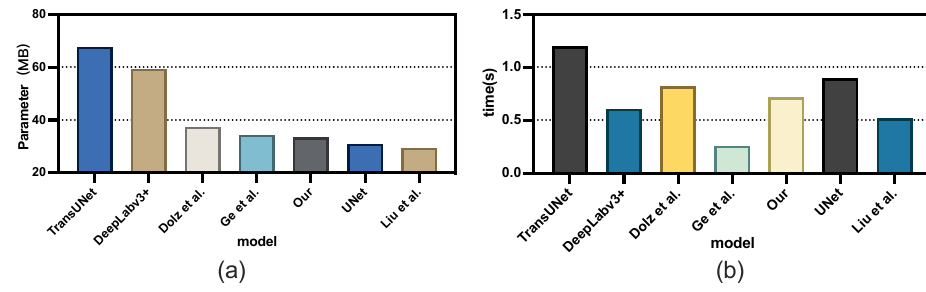
Figure 8. Parameter ( a ) and inference time ( b ) comparison of different models